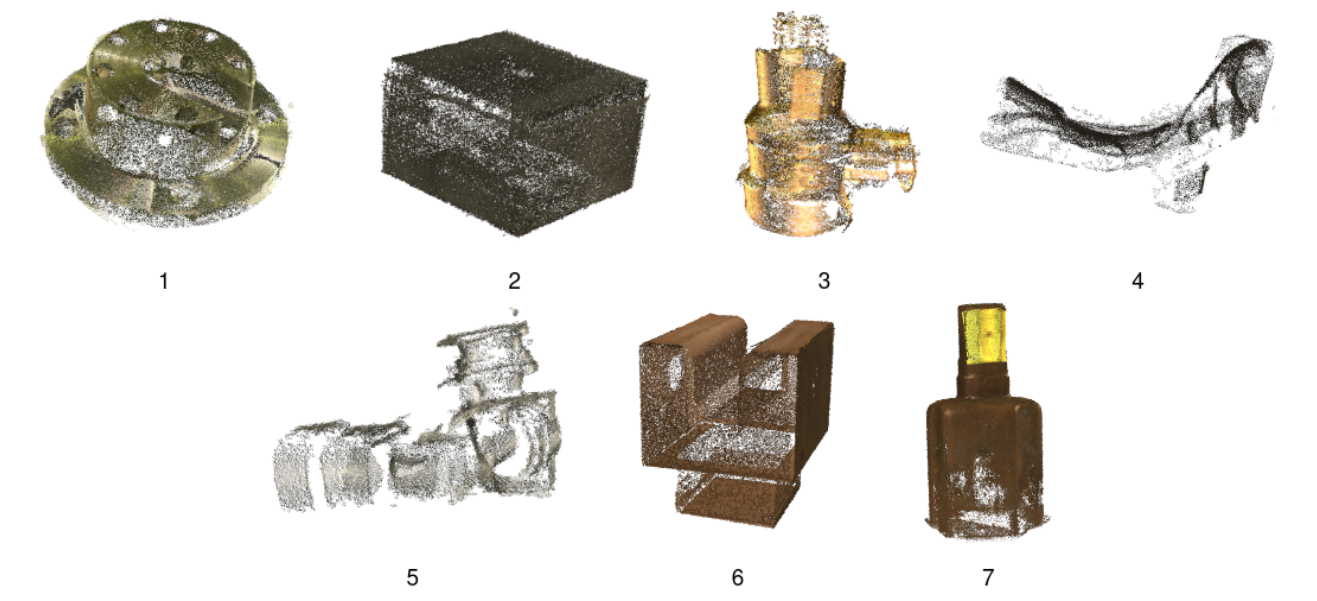
Figure 10. Reconstructed models of the 7 industrial parts.